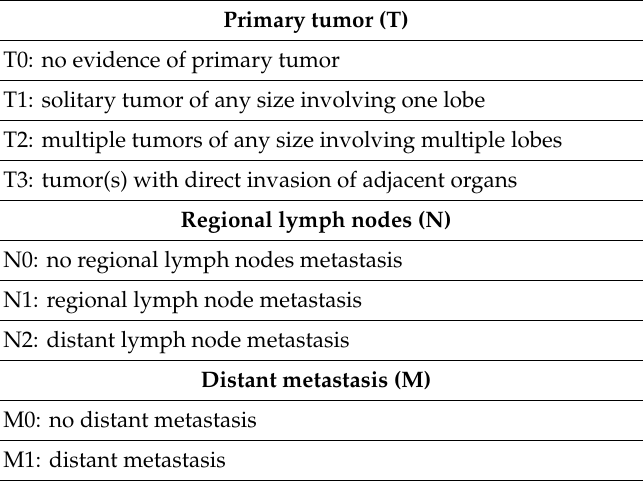
Table 4. TNM staging system for canine hepatocellular